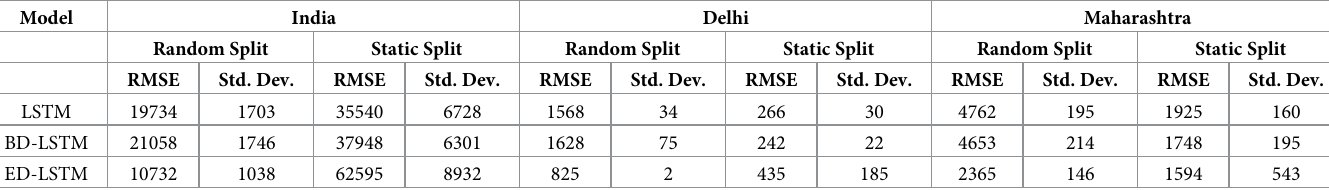
Table 7. Univariate model performance accuracy on test dataset (RMSE mean and standard deviation for 30 experimental runs across 4 prediction horizons). Model